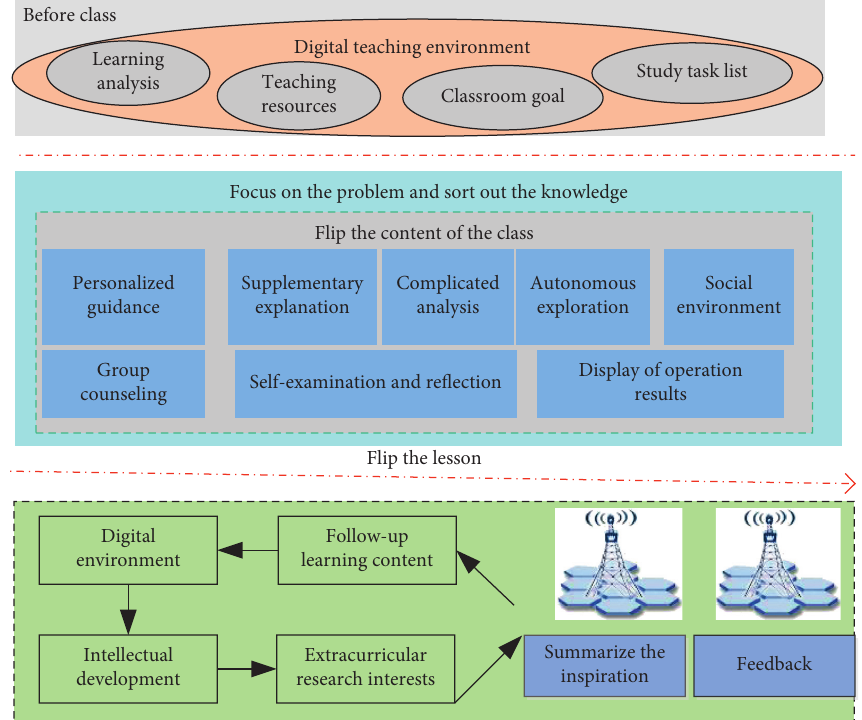
Figure 1: Implementation framework of flipped classroom teaching